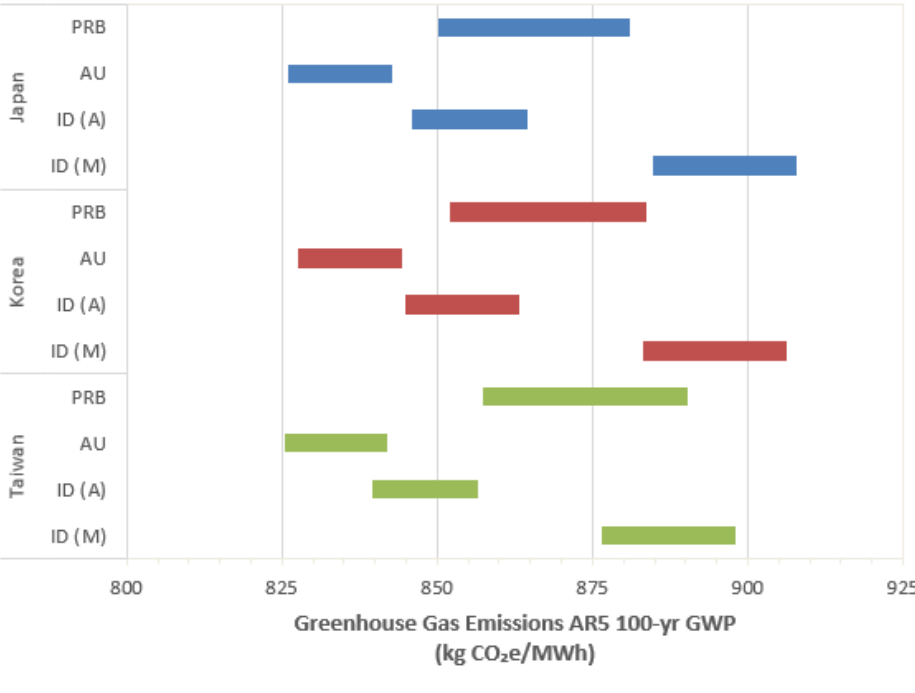
Figure 3. Uncertainty ranges for U.S. (PRB), Australian (AU), and Indonesian (ID) coals exported to Japan, South Korea (Korea), and Taiwan (non-CCS cases only).